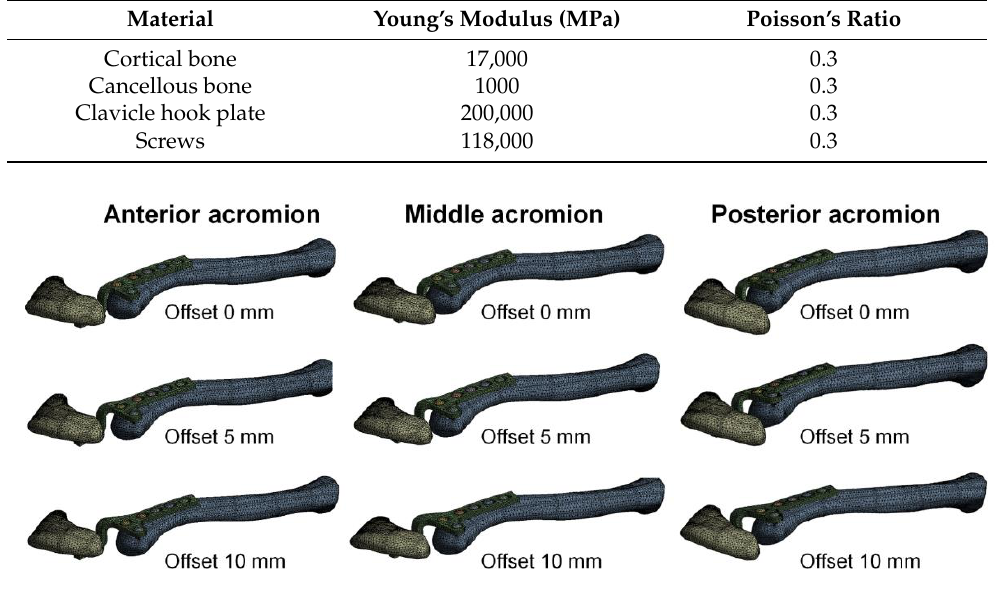
Figure 5. The mesh of the computer models used in this study.